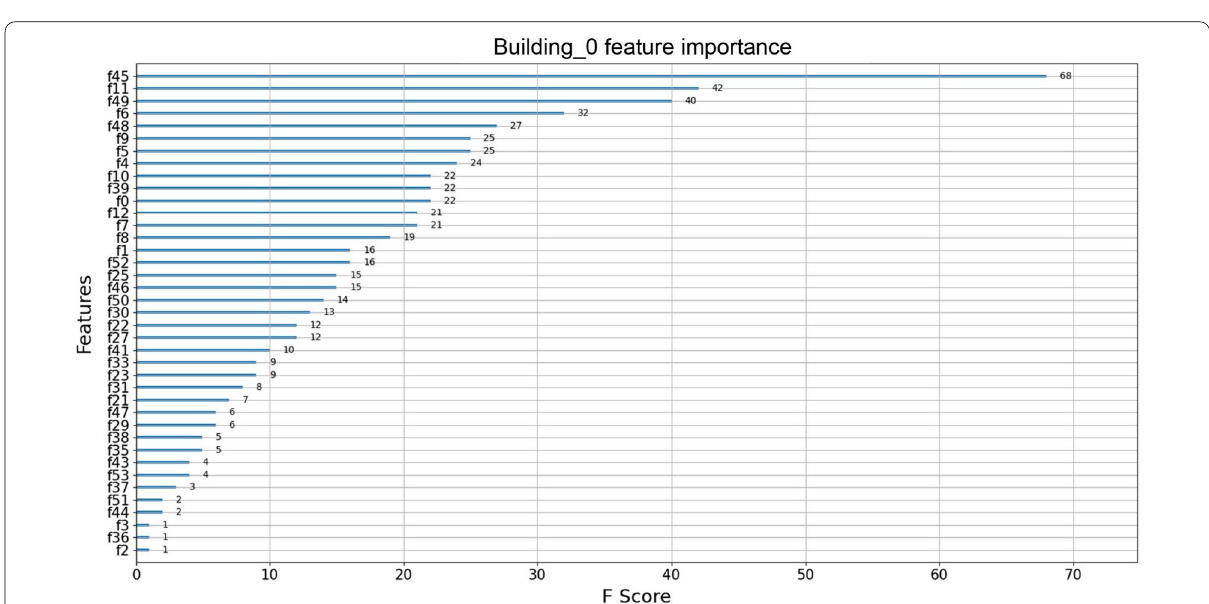
Fig. 10 The score of each feature using the data which comes from